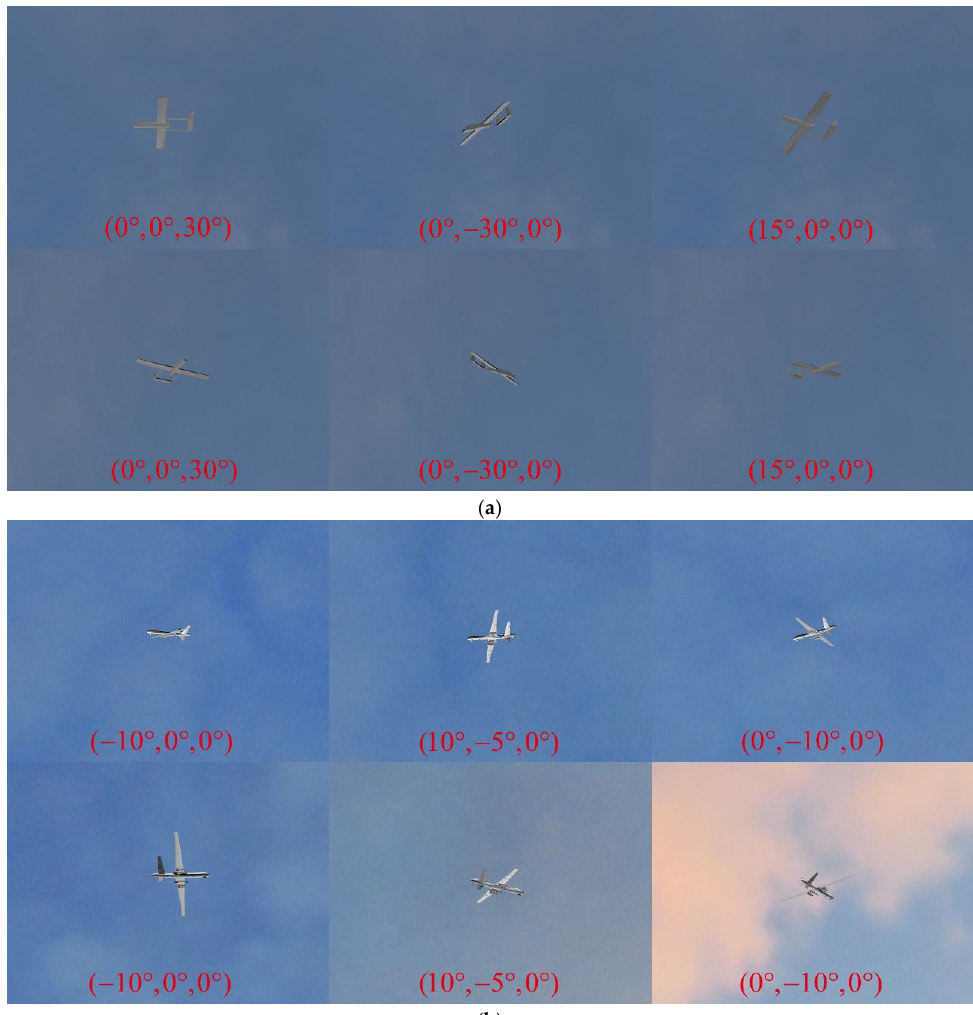
Figure 11. Examples of simulated image pairs generated by the 3ds Max rendering engine: ( a ) Image pairs of Model 1; ( b ) Image pairs of Model 2.